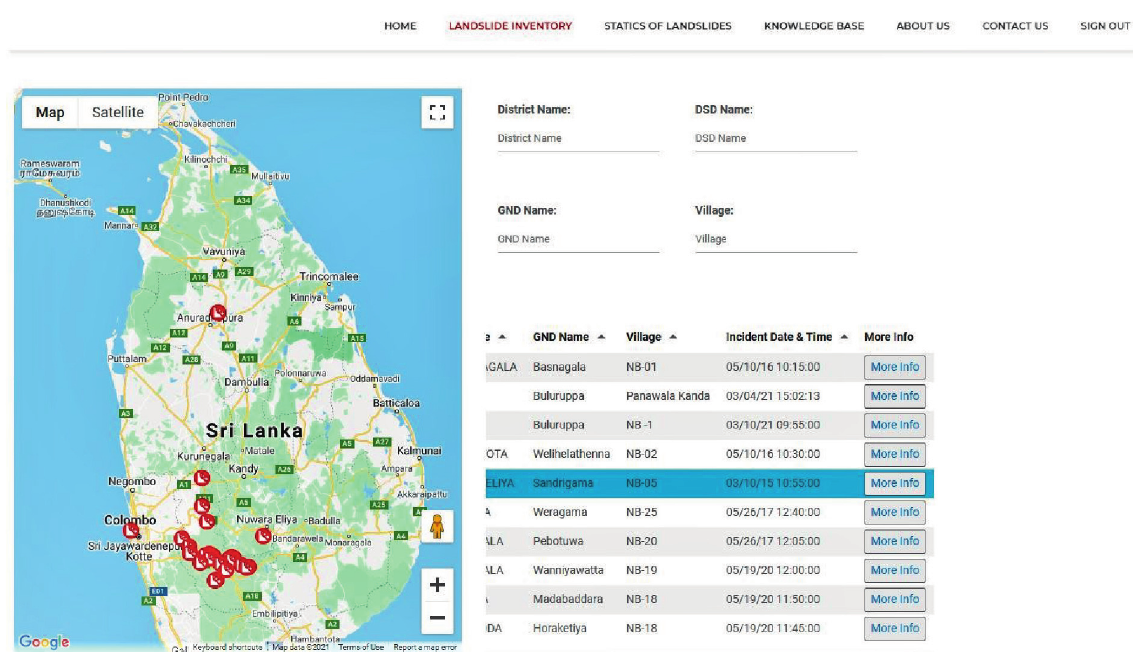
Figure 5: Landslide inventory in the PLI web